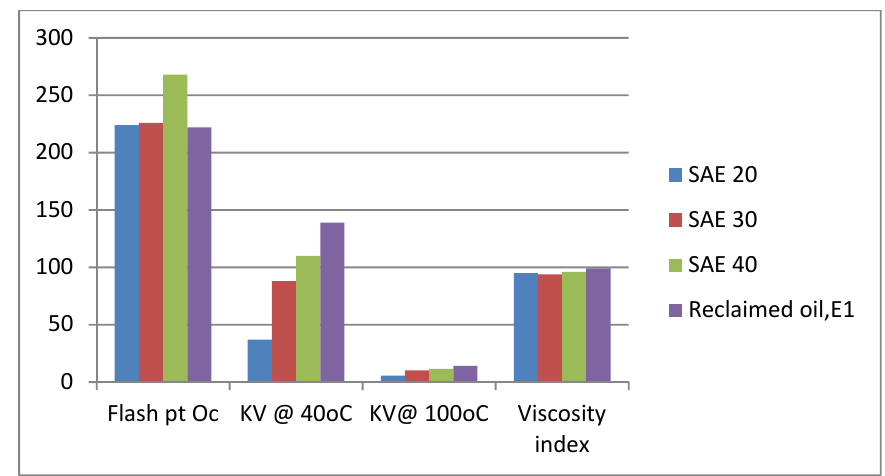
Figure 3. Comparison between SAE 20, SAE 30, SAE 40 and reclaimed oil (E1).